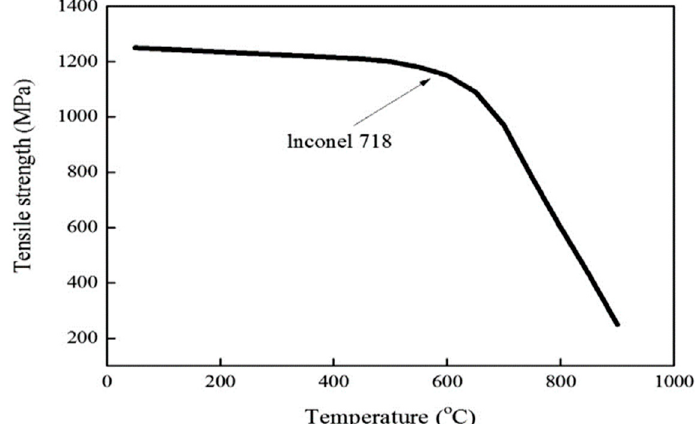
Figure 9. Tensile strength of Inconel 718 according to temperature (reproduced from [24], with permission from ELSEVIER, 2010).